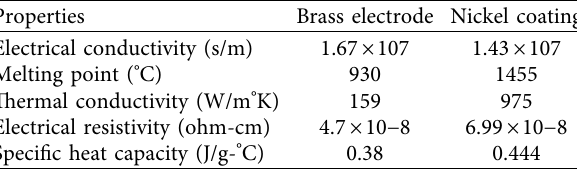
Table 2: Chemical properties of electrode.